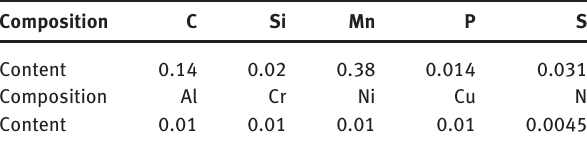
Table 1: The chemical composition of cold-reduced sheet (wt%). Composition